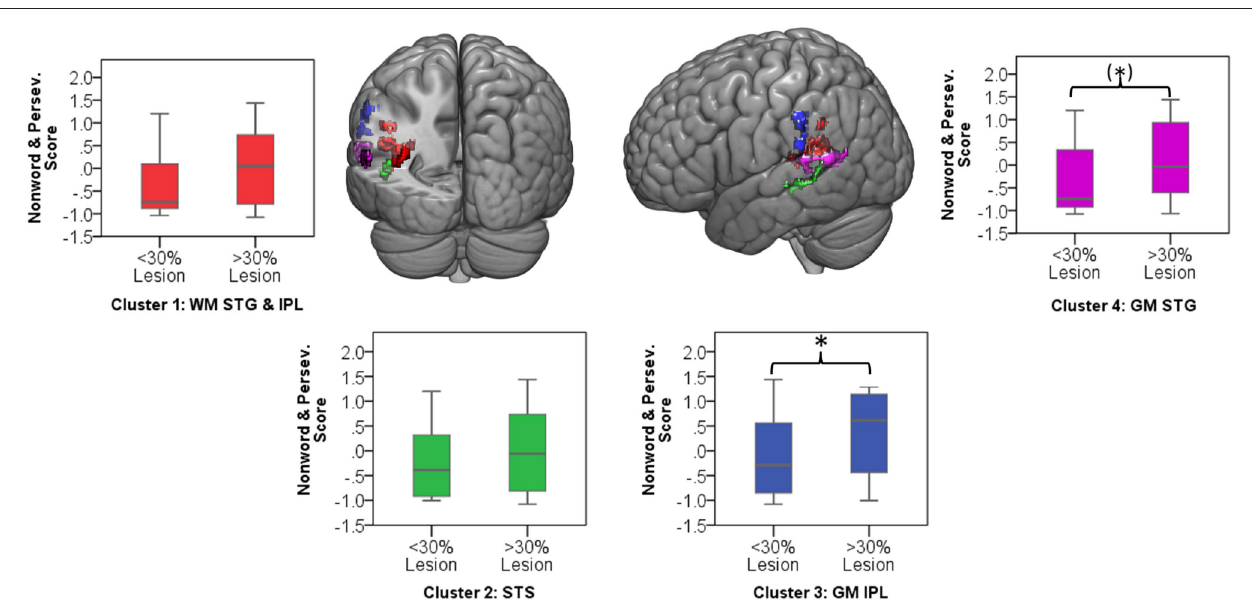
FIGURE 5 | Color areas display four regions of interest derived from VLSM clusters. Graphs indicate jargon score for low and high lesion overlap group in each ROI. Ceiling performance on jargon score = − 1.07. *significant group difference; (*) borderline significant group difference. WM, white matter; GM, gray matter; STG, superior temporal gyrus; IPL, inferior parietal lobe; STS, superior temporal